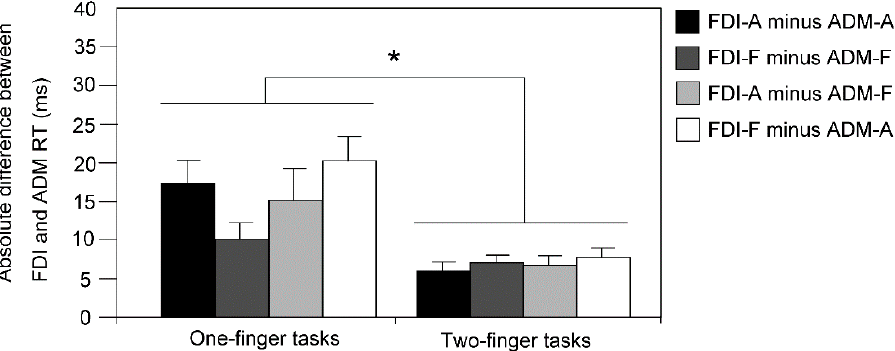
Figure 4. The absolute difference in the RT between the FDI and ADM (AD). Bars indicate the mean; error bars indicate the standard error. An asterisk indicates a significant difference ( p < 0.05).